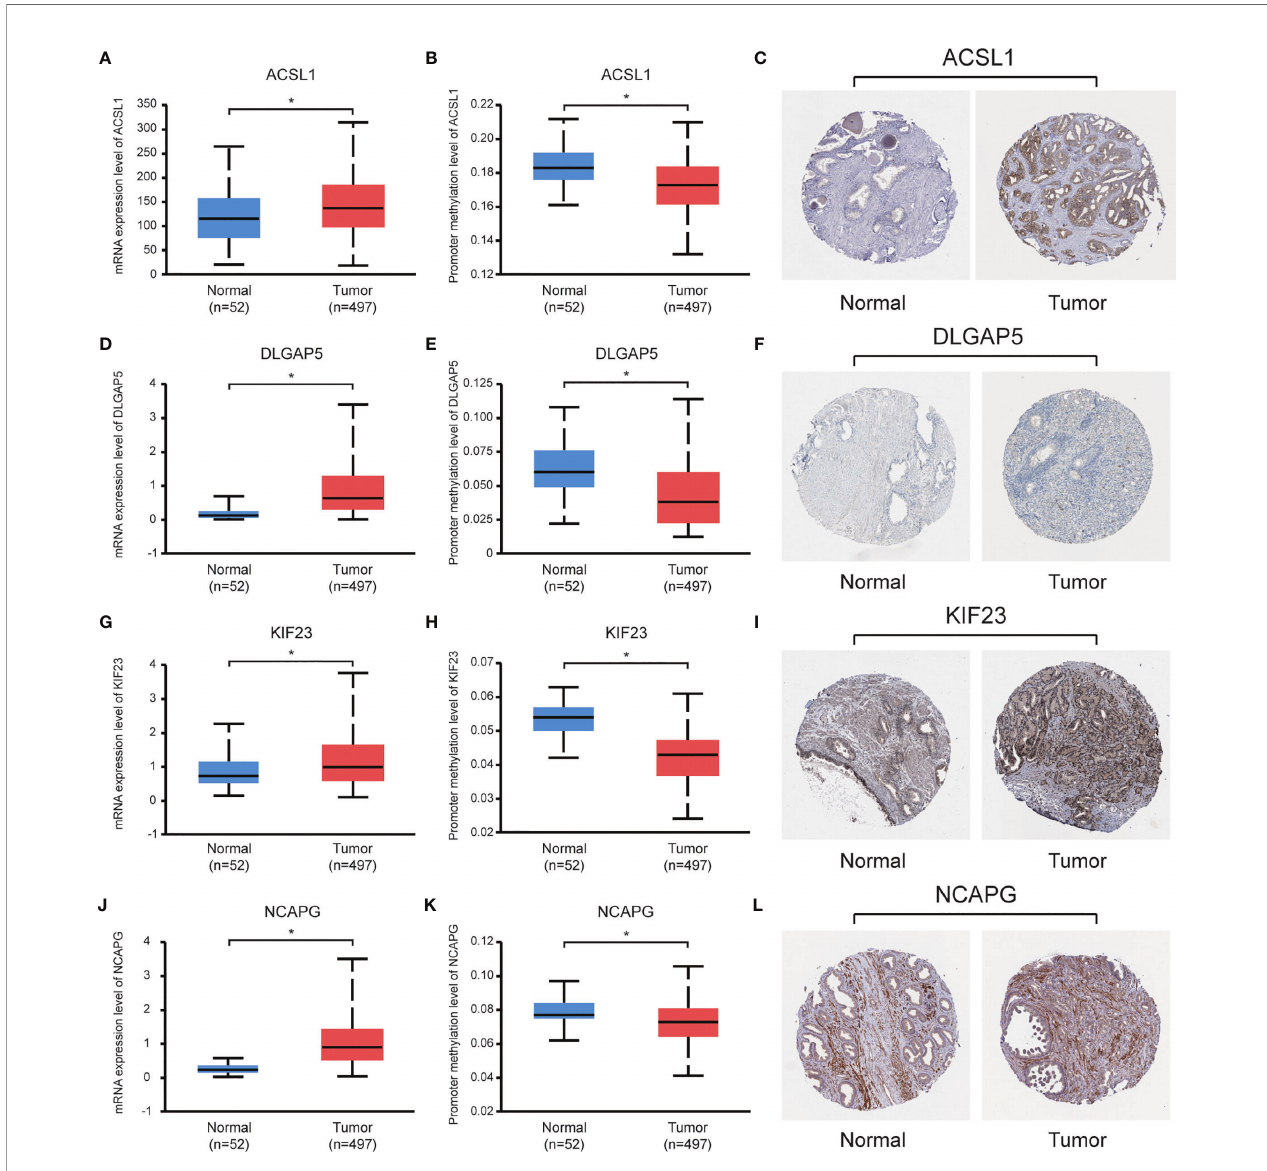
FIGURE 6 | Validation of the hub genes using online databases. (A , D , G , J) Expression levels of the hub genes in PCa and normal prostate tissues; (B , E , H , K) Promoter methylation levels of the hub genes in PCa and normal prostate tissues; (C , F , I , L) Immunohistochemical staining of the hub genes in PCa and normal prostate tissues. *P <